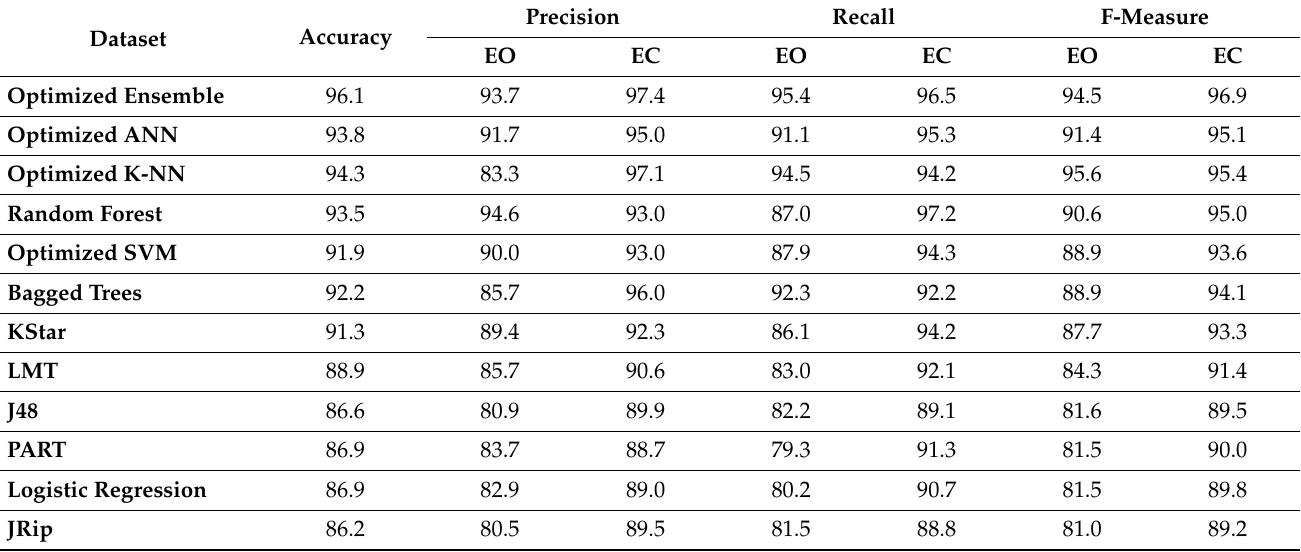
Table A1. The performance of the classifiers on Dataset CP10-M .